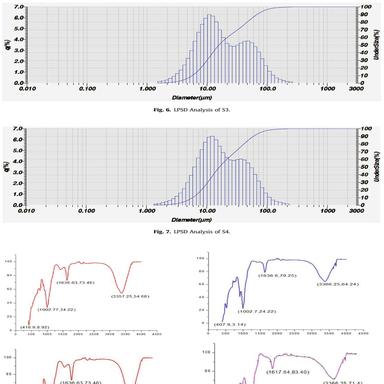
a) FTIR result of S-1, b) FTIR result of S-2, c) FTIR result of S-3 d) FTIR result of S-4.